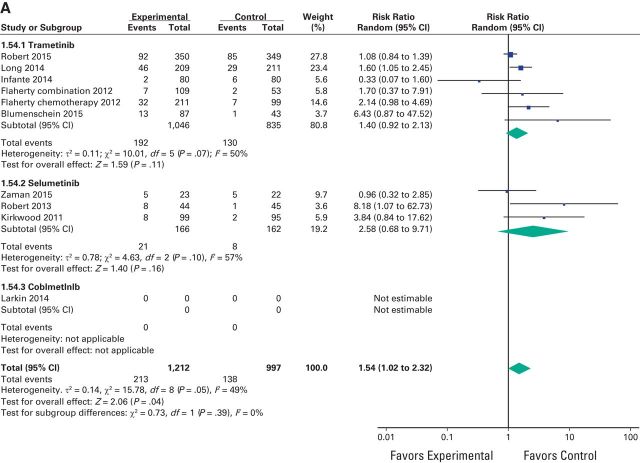
Forest plots of risk ratio of (A) all-grade hypertension associated with MEK inhibitors versus control and (B) high-grade hypertension associated with MEK inhibitors versus control; the size of squares corresponds to the weight of the study in the meta-analysis.